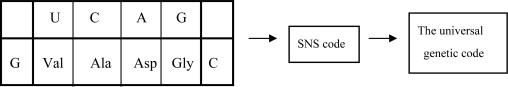
GNC-SNS hypothesis on the origin and evolutionary pathway of the genetic code, suggesting that the universal genetic code originated from GNC primeval genetic code through SNS primitive genetic code.